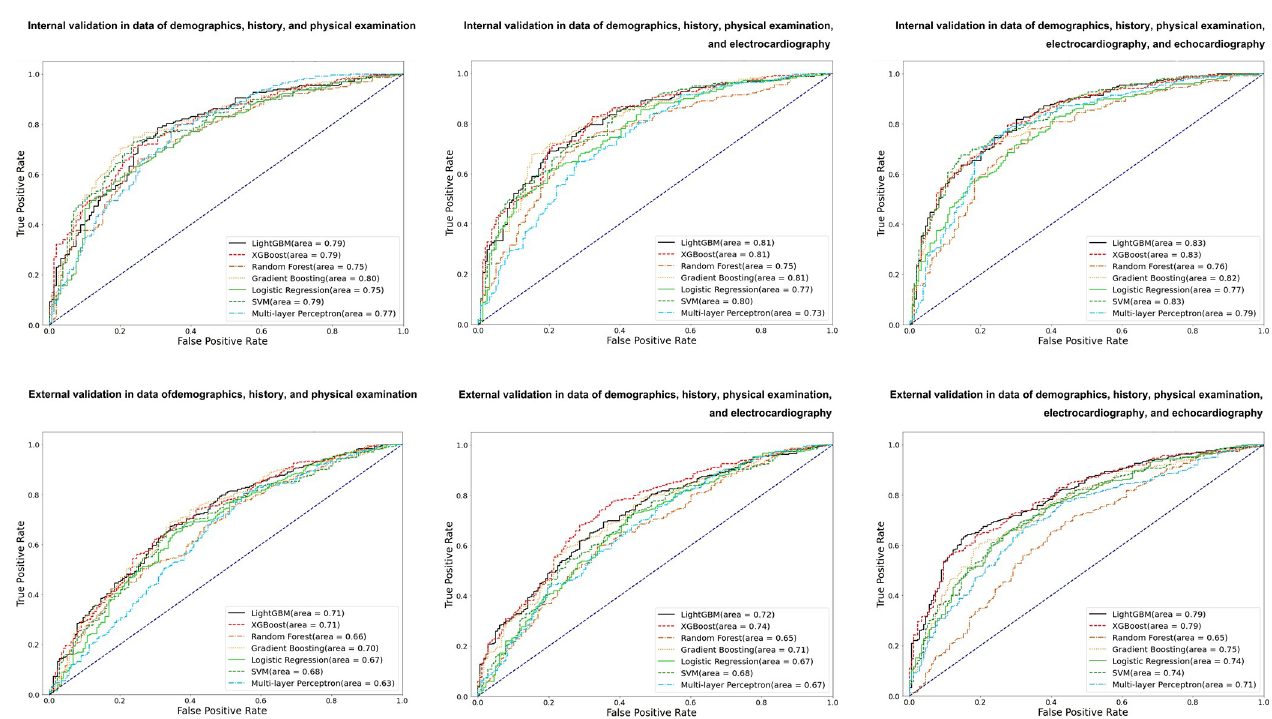
Fig 2. Internal and external validation according to dataset. Left column: Performance using demographic, history, and physical examination data. Middle column: Performance adding electrocardiographic data. Right column: Performance adding electrocardiographic and echocardiographic data. Area indicates the area under the receiver operating characteristic curve; lightGBM, light gradient boosting machine; XGBoost, extreme gradient boosting: SVM, support vector machine.